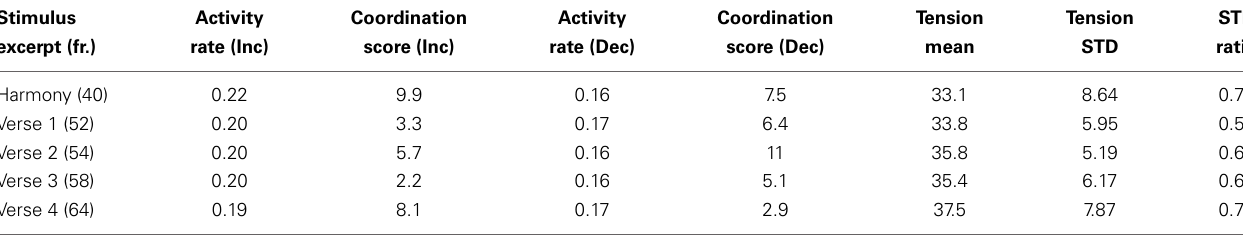
Table 4 | Summary statistics of tension-rating collections per verse and harmonic reduction.